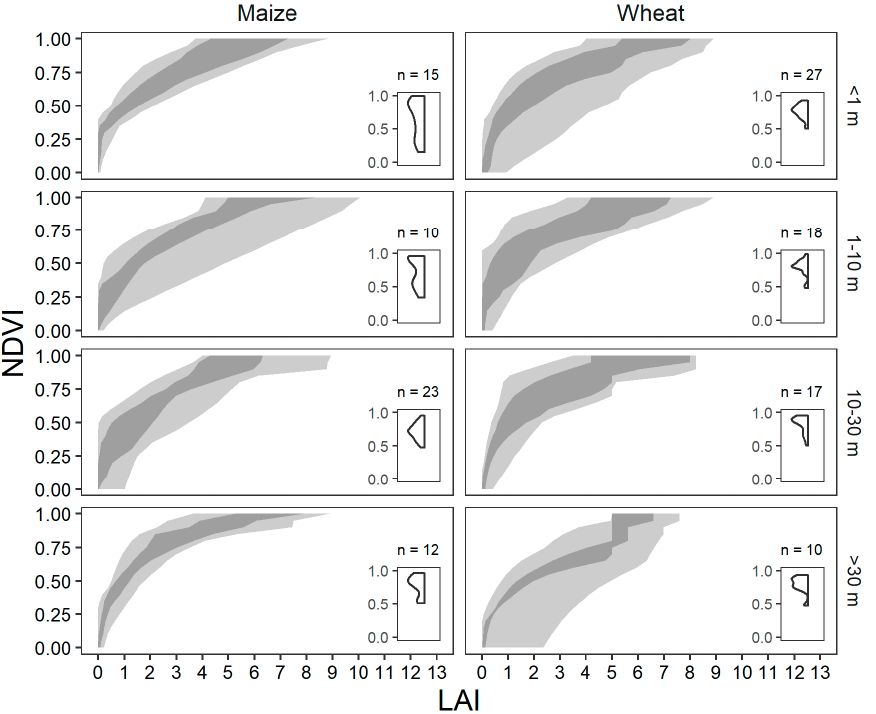
Figure 4. Correlation plots between the positive part of the normalized difference vegetation index (NDVI) existence range and leaf area index (LAI) for maize and wheat, sorted by sensor spatial resolution. The grey shadows indicate the 5–95th (light grey) and the 25–75th percentile (dark grey) of the LAI values obtained from the equations considered. The half-violin plot shows the R 2 distribution; n is the number of equations.